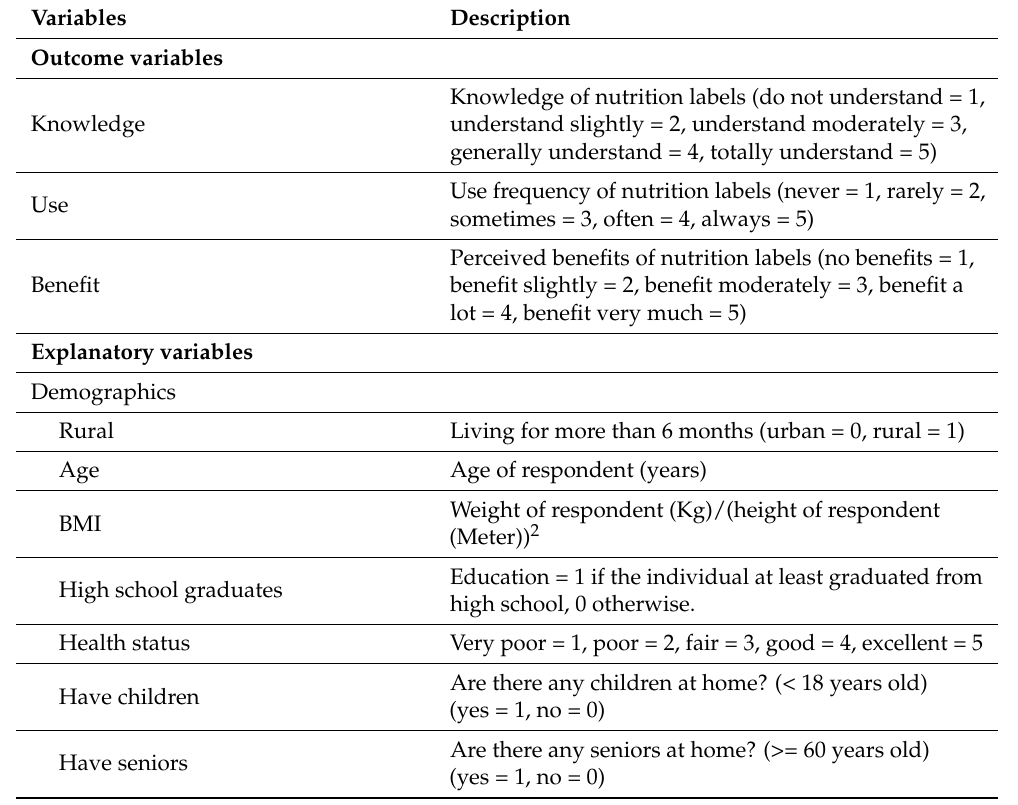
Table 1. Variable